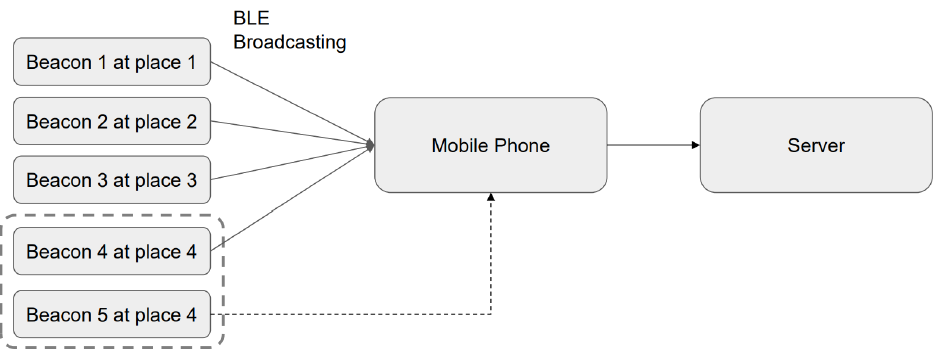
Figure 9. The presentation attack (faked Beacon 5 placed in the place of Beacon 4, leading to delivery of incorrect LBS information).